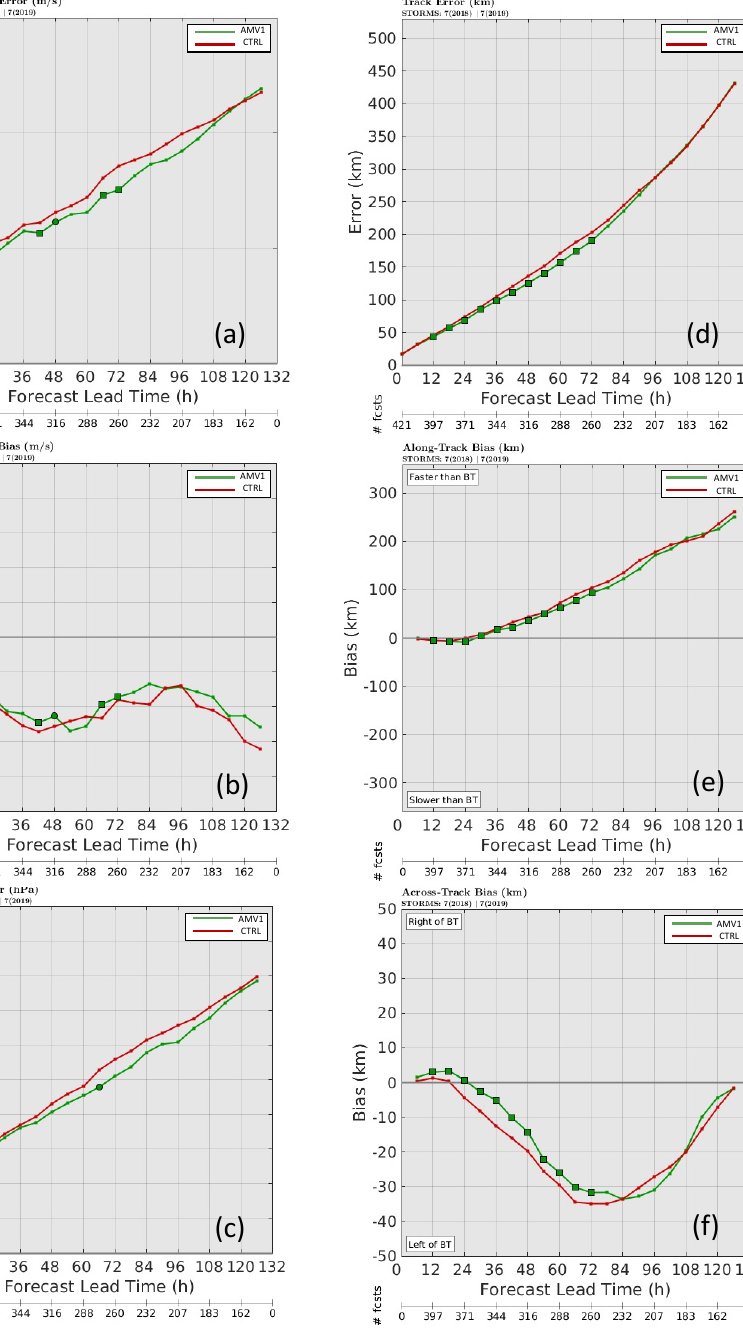
Figure 11. Verification statistics for the 2018 and 2019 hurricane seasons in the Atlantic Ocean for control (red) and experiment AMV1 (green). AMV1 includes SWIR and VIS AMVs. It also uses the new QCs and error profiles. Panel ( a ) is wind speed error measured using maximum sustained 10 m winds [m/s], ( b ) is wind speed bias [m/s], ( c ) is pressure error [hPa], ( d ) is track error [km], ( e ) is along-track bias [km] and ( f ) is across-track bias [km]. Squares (circles) indicate statistical significance at the 95% (90%) confidence level based on a paired t -test with adaptive serial correlation. The number of samples used in deriving these statistics is shown in secondary axis.